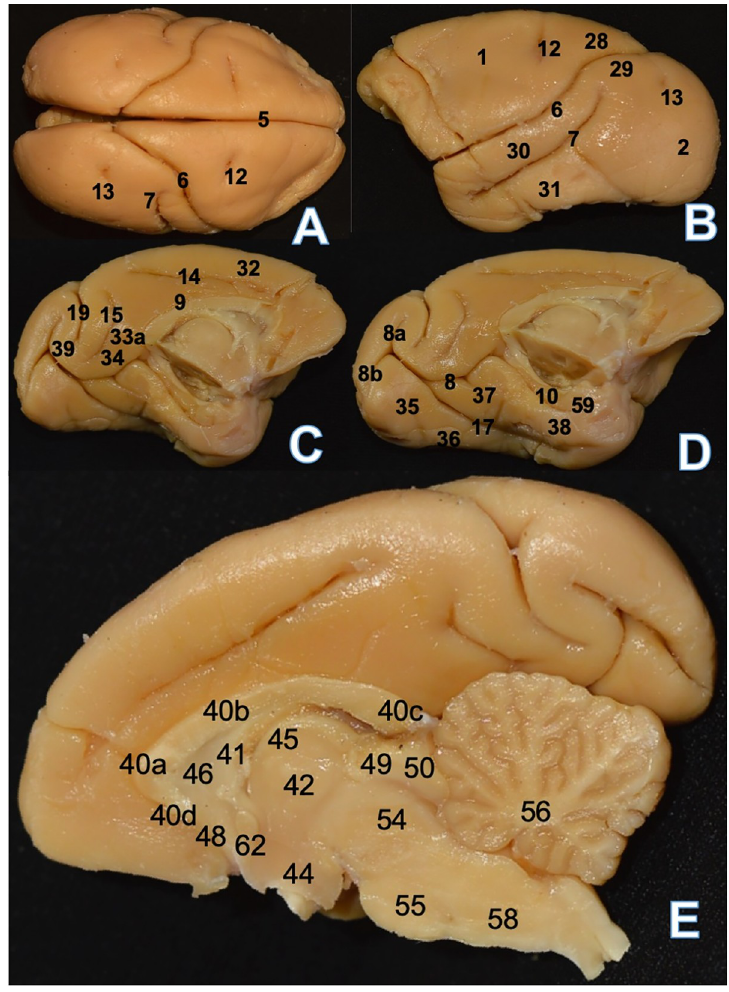
Fig 2. Saimiri ustus (SU1) encephalon. (A) Superior view: 5. Sagittal/longitudinal fissure 6. Lateral sulcus 7. Superior temporal sulcus 12. Central sulcus 13. Lunatus sulcus. (B) Lateral view: 1. Frontal lobe 2. Occipital lobe 6. Lateral sulcus 7. Superior temporal sulcus 12. Central sulcus 13. Lunatus sulcus 28. Parietal rostral gyrus 29. Parietal caudal gyrus 30. Superior temporal gyrus 31. Inferior temporal gyrus. (C) Medial view: 9. Sulcus of the corpus callosum 14. Cingulate sulcus 15. Subparietal sulcus 19. Parieto-occipital sulcus 32. Medial frontal gyrus 33a. Cingulate gyrus isthmus 34. Precuneus 39. Cuneus. (D) Medial view: 8. Calcarine sulcus 8a. Superior ramus 8b. Inferior ramus 10. Hippocampal sulcus 17. Collateral sulcus 35. Occipital gyrus 36. Fusiform gyrus 37. Lingual gyrus 38. Para hippocampal gyrus 59. Uncus. E. Medial view: 40a. Corpus callosum genu 40b. Corpus callosum trunk 40c. Corpus callosum splenium 40d. Corpus callosum rostrum 41. Fornix 42. Thalamus 44. Hypothalamus 45. Medullary stria of thalamus 46. Septum pellucidum 48. Anterior commissure 49. Superior colliculus 50. Inferior colliculus 54. Mesencephalon 55. Pons